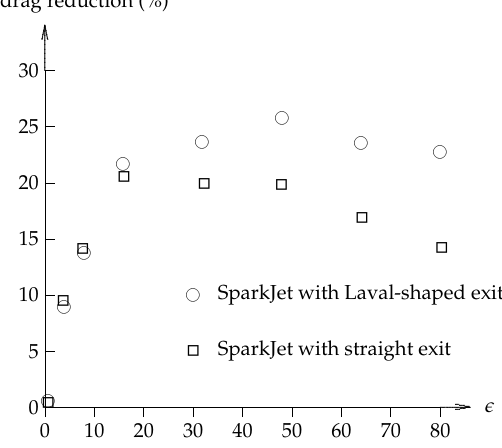
Figure 39. Average drag reduction vs dimensionless energy. Figure 35. Average drag reduction vs. dimensionless